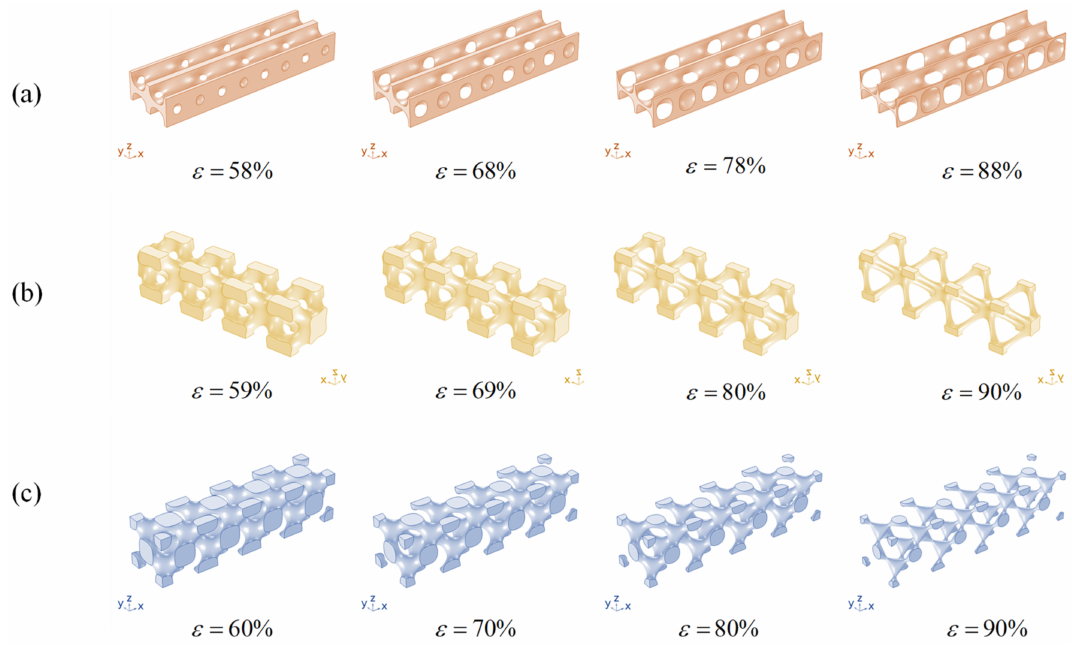
Figure 13. TPMS-based spacers structure ( a ) CLP, ( b ) IWP, and ( c ) D with four types of porosity in each case. From left to right, the porosity of spacer-filled channels increases in